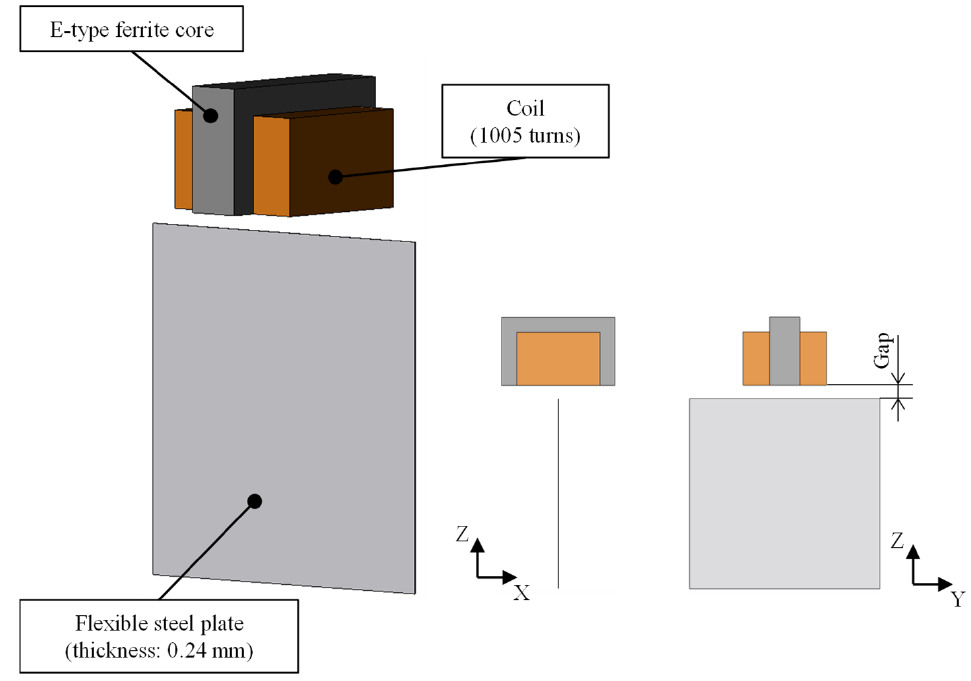
Figure 4. Model for magnetic field analysis.